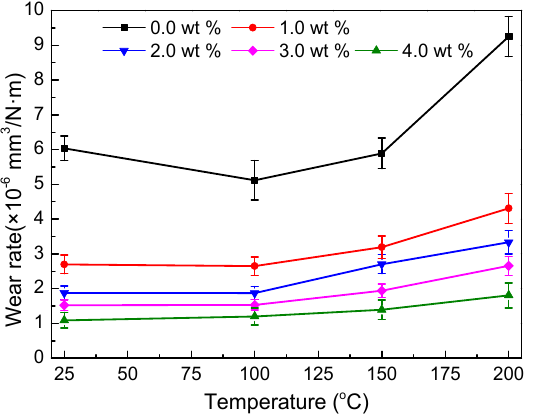
Figure 7. Wear rate of the polymer composite coatings under various test temperatures.